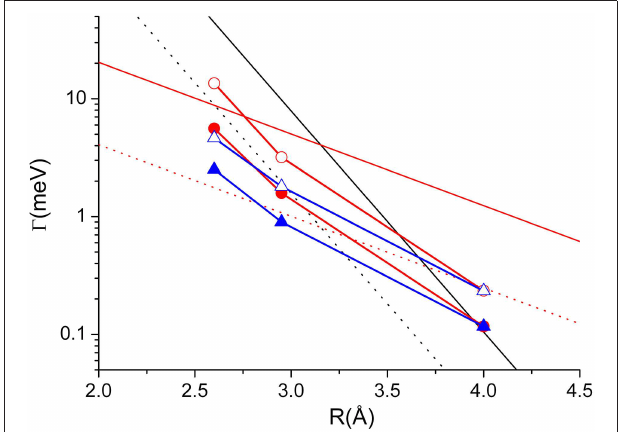
FIGURE 5 | The A 6 − 6 (R) (full black) A 5 − 5 (R) (dashed black), A 6 − 5 (R) (full red) and A 5 − 6 (R) (dashed red) coupling terms determining direct and indirect mechanism s in auto-ionization reactions of Ne * -Kr system. Open and closed red circles represent the Γ components associated to 3 P 0 - 2 P 3 / 2 and 3 P 2 P 0 - 1 / 2 state to state processes; Open and closed blue triangles represent the Γ components associated to 3 P 2 - 2 P 3 / 2 and 3 P 2 - 2 P 1 / 2 state to state processes. Note that in the exit channels the reaction probability is weighted on the different degeneracy of J = 3/2 and J = 1/2 states of the ionic